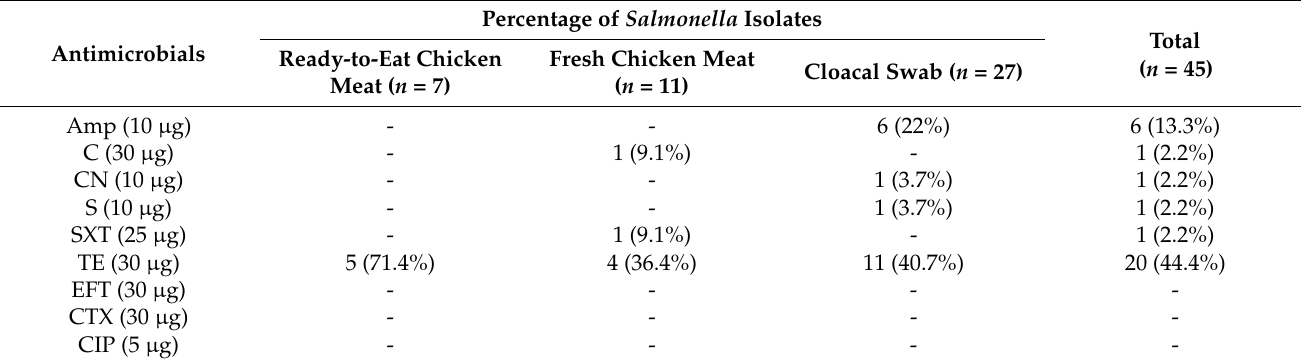
Table 1. S. Enteritidis isolates showing resistance to antimicrobial drugs tested.